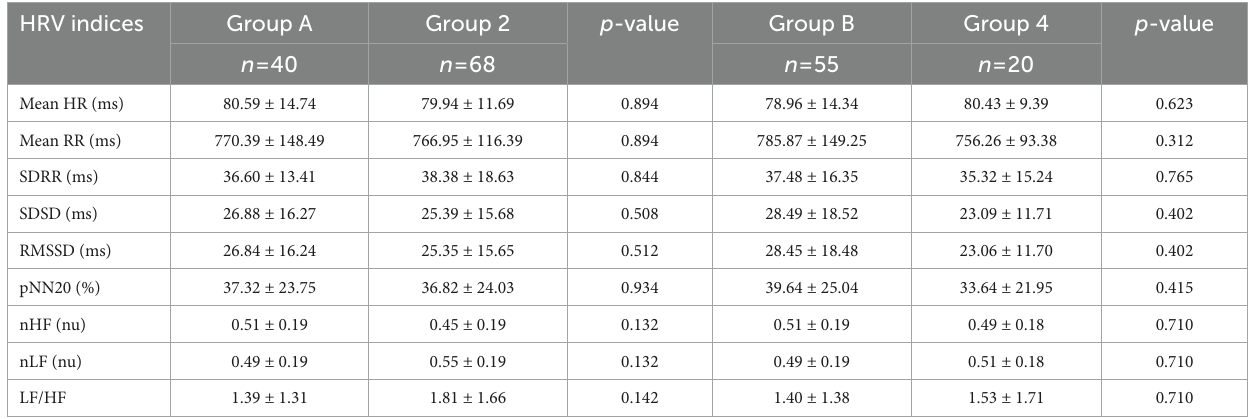
TABLE 4 Comparison of HRV indices between groups A and 2, and between groups B and 4. HRV indices Group A Group 2 p -value Group B Group 4 p -value n = 40 n = 68 n = 55 n = 20